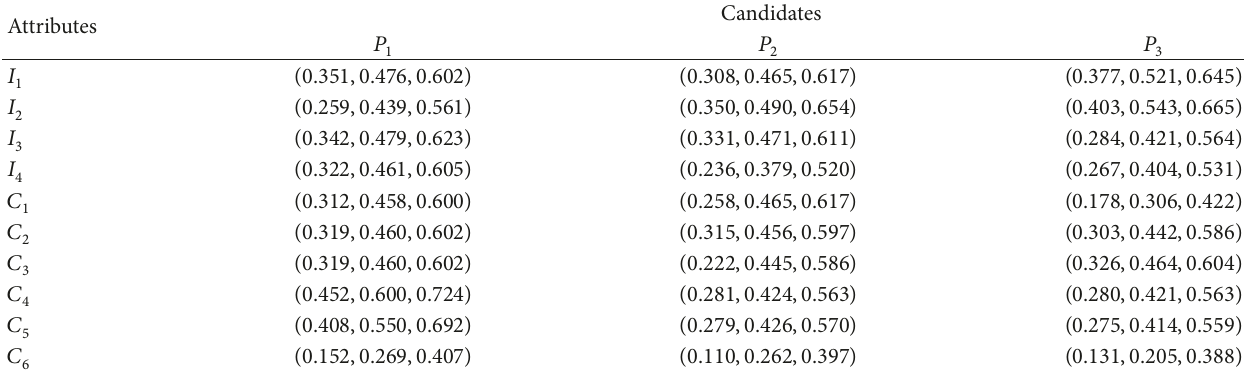
Table 7: The integrated decision matrix.